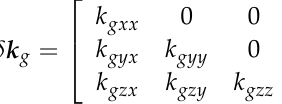
compared these two methods